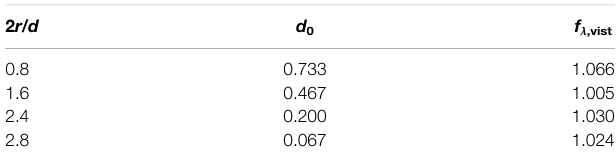
TABLE 3 | Damping and the viscous correction coef fi cients of fl oaters with different bottom shapes. 2 r / d Bottom shapes λ vist (kg/s) λ 33